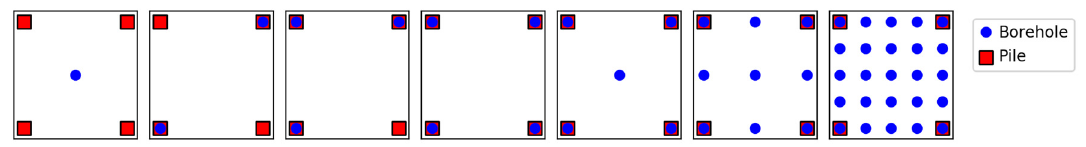
Figure 3. Examples of boreholes arranged in regular grids over the building footprint, in the case of four